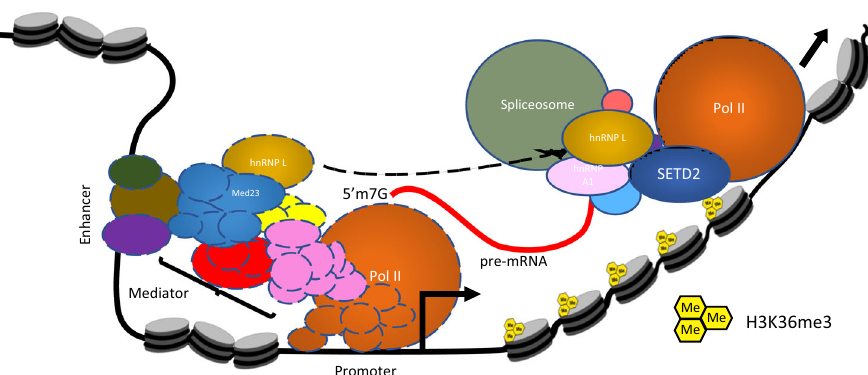
Fig. 7 The SHI domain regulates SETD2 activity. a Cartoon illustrating the SETD2 constructs along with their known domains that were used to compare the ability to deposit H3K36me3 in KO cells. b , c Western blot with the depicted antibodies of whole-cell lysates of KO cells expressing SETD2 mutants. The experiment was repeated at least fi ve times all yielding similar results. d Bar graph showing H3 normalized H3K36me3 signal intensity of data depicted in ( c ). n = 4 independent biological samples examined in four independent experiments. Unpaired t test (two-tailed) was performed. p -value <0.05 (FL Δ SRI vs FL = 0.0071; FL Δ SHI vs FL = 0.0344; FL Δ SRI Δ SHI vs FL = 0.0013) was considered signi fi cant. Data are presented as mean values with standard error of mean. e , f , g , h Metagene plot and boxplot depicting the distribution of H3K36me3 upon expression of SETD2 FL, FL Δ SRI, and FL Δ SHI in setd2 Δ 293T cells. For each sample n = 2 independent biological samples examined in the same sequencing run. In the boxplots, the black line inside the box shows the median. The box bottom and top border correspond to 25th and 75th percentiles (Q1 and Q3, respectively). The whiskers represent ranges from Q1 − 1.5 * IQR to Q3 + 1.5 * IQR where IQR stands for interquartile range (Q3 – Q1). Data points outside the whiskers could be outliers and are marked as black dots. AWS associated with SET, SET Su(var)3 – 9, Enhancer-of-zeste and Trithorax, SRI Set2-Rpb1 interaction, SHI SETD2-hnRNP interaction, NLS